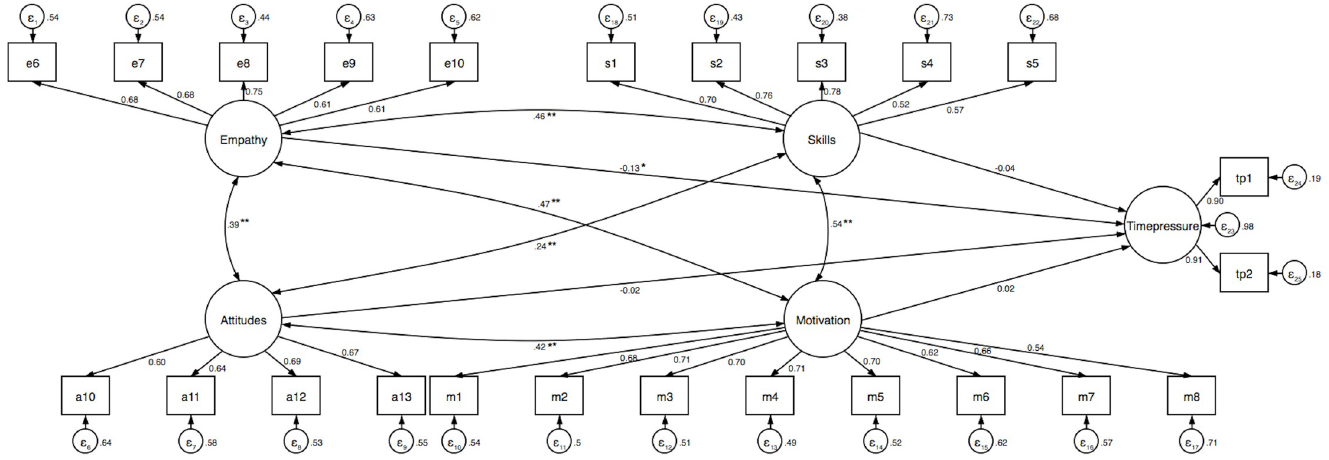
Fig 1. Structural equation model examining the association between cross-cultural competence and perceived time pressure. Standardized coefficients are reported and the significance levels of paths and covariates presented here are for the standardized regression coefficients. Model adjusted for gender, age, employment sector, and frequency of interacting with patients and colleagues from different cultures. Goodness-of-fit indices: χ 2 (243) = 1092.38, p < .001, RMSEA = 0.06, CFI = 0.89, SRMR = 0.06 (index obtained from the estimation of goodness-of-fit of the model tested with the maximum likelihood, n = 820). R 2 time pressure = 2.4%. � p < .01. �� p < .001.